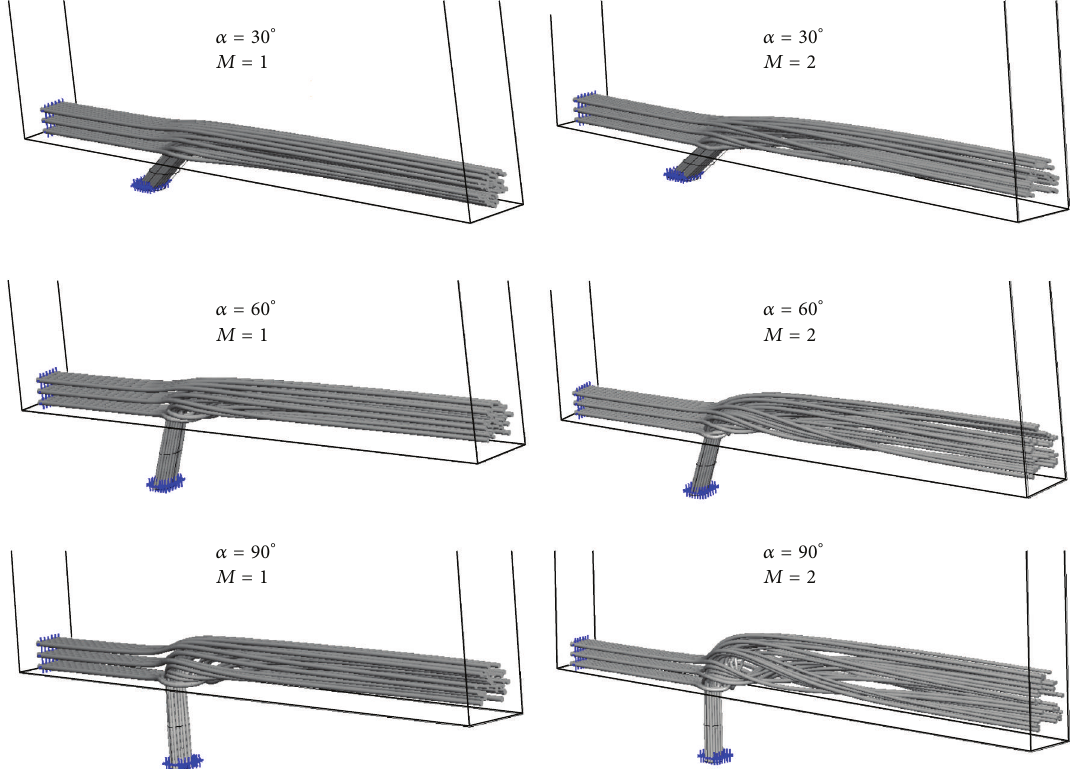
Figure 29: Stream tubes on flat plate with cylindrically hole shape (LFDSA-0-0).